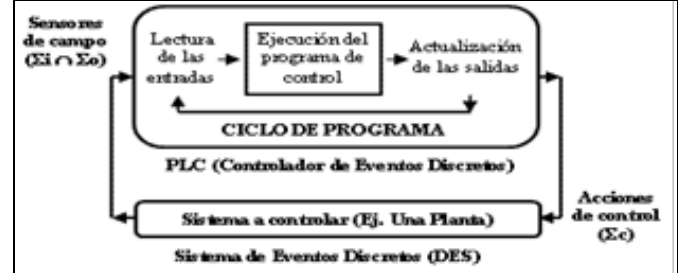
Figura 1: Control de un DES con